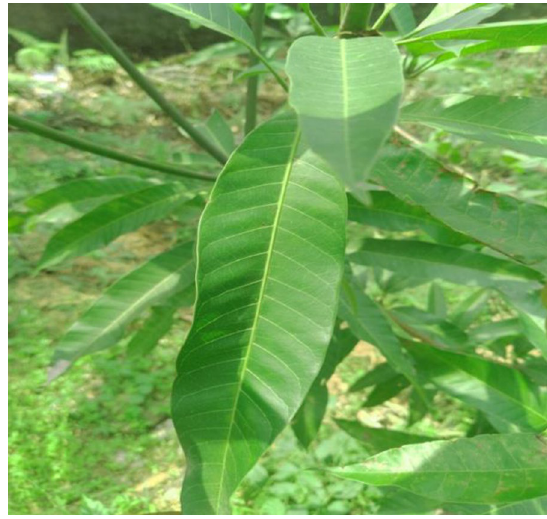
Fig. 8 Mangifera indica leaves. Size: 79.7 mm by 83.2 mm.